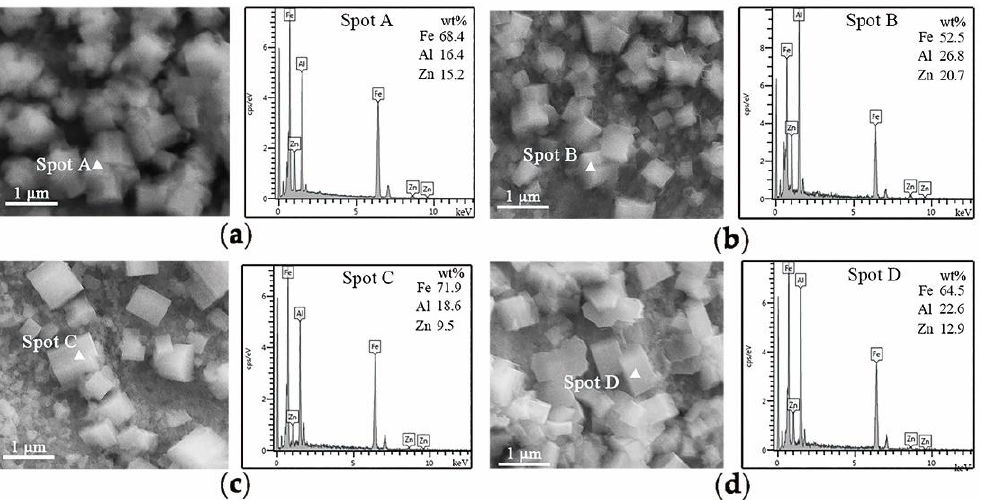
Figure 2. SEM micrographs of the surface after removal of the outer zinc layer; ( a ) 3Mn +10 °C, ( b ) 3Mn − 30 °C, ( c ) 10Mn +10 °C, ( d ) 10Mn − 30 °C.